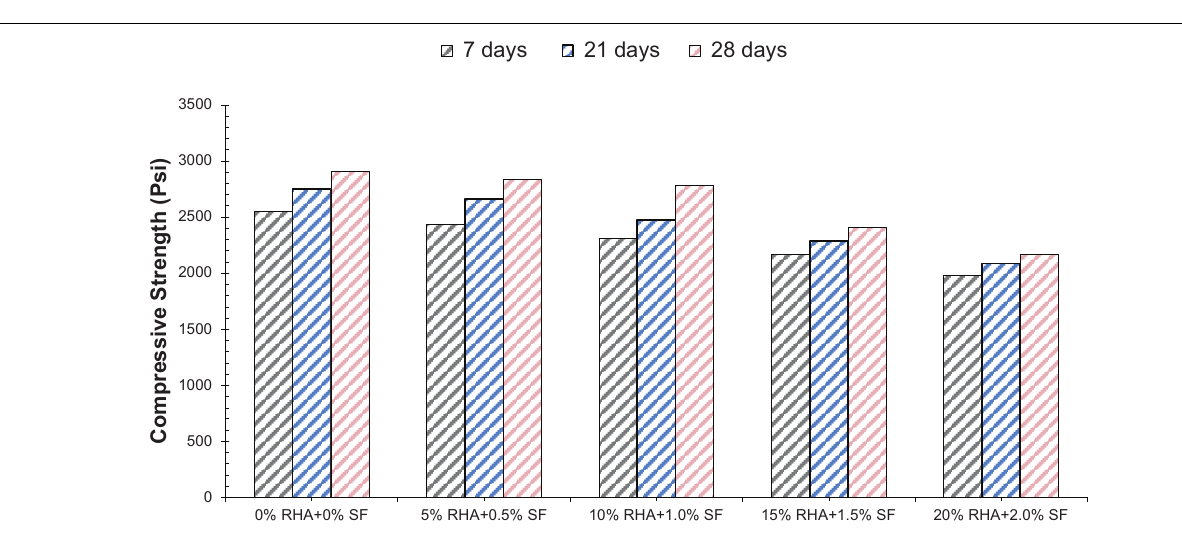
FIGURE 4 | Compressive strength (with steel fibers and superplasticizer).